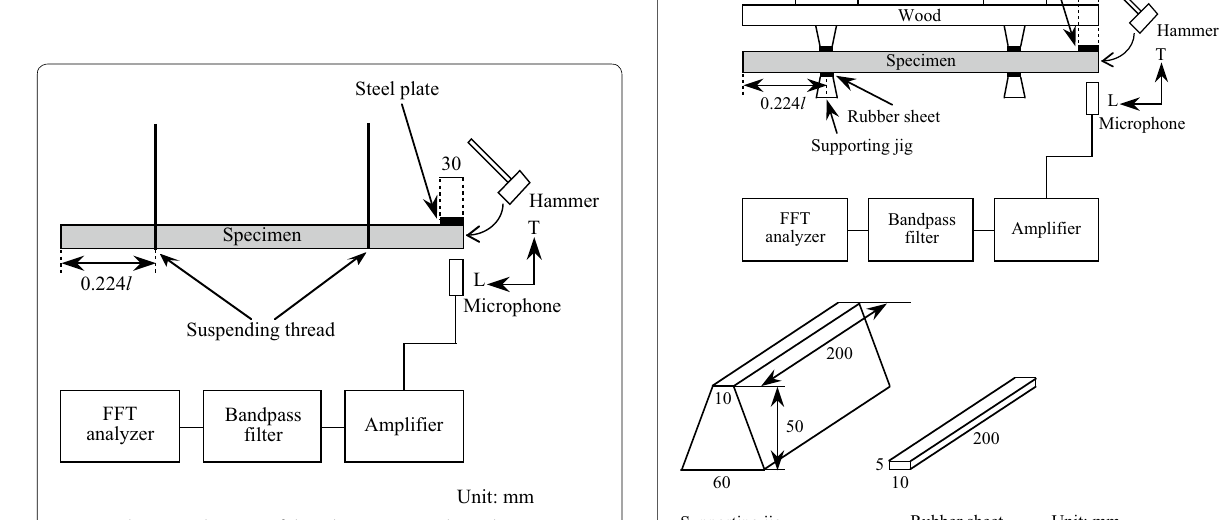
Fig. 2 Schematic diagram of the vibration test, where the specimen is suspended by two threads Fig. 3 Schematic diagram of the vibration test for the piled